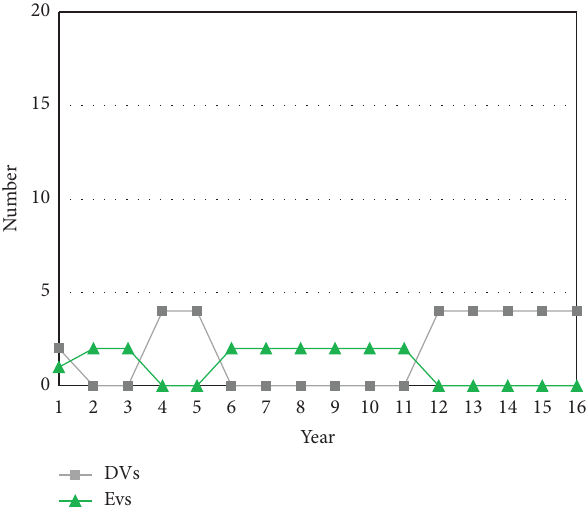
Figure 3: Number of purchased vehicles during the planning period.